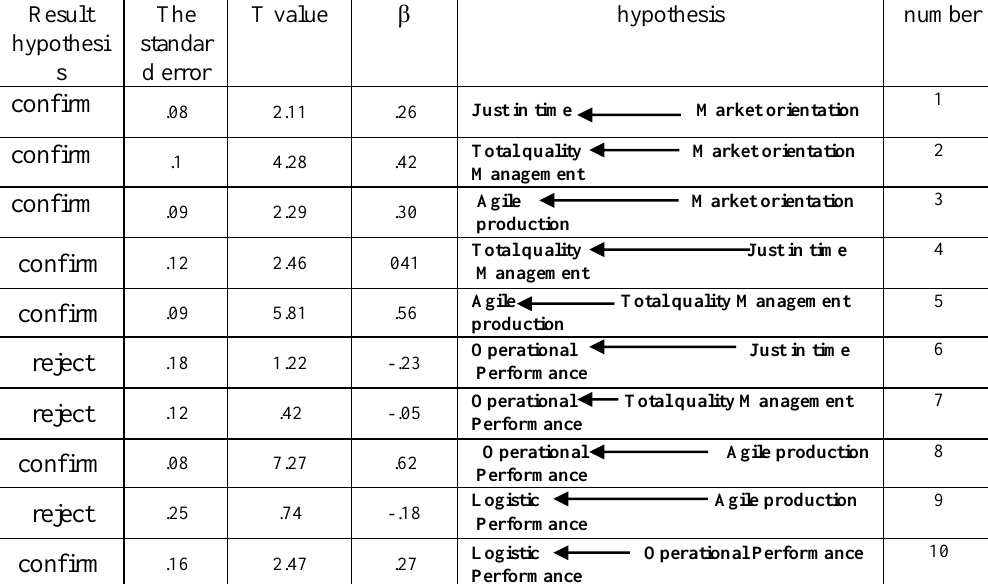
Table 3. Confirming or rejecting the research hypotheses